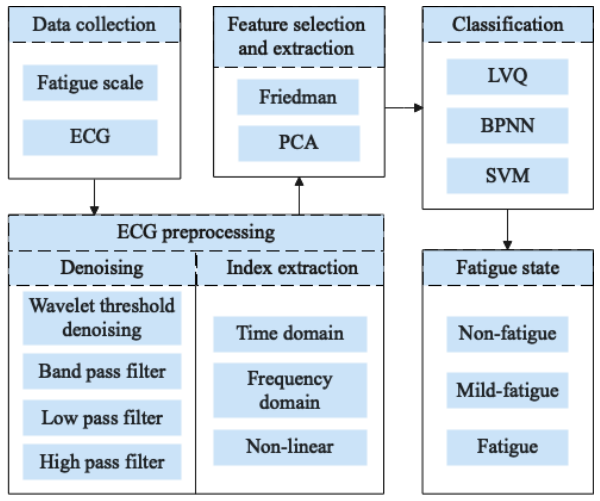
Figure 1. Research architecture diagram.